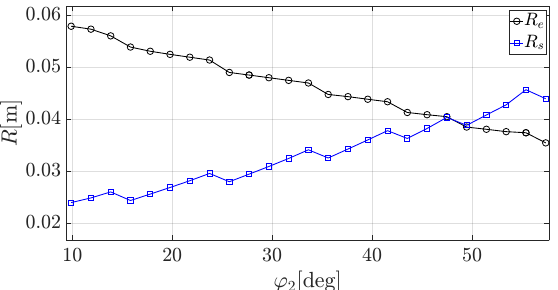
Figure 4. Entraining ( R e ) and side leakage ( R s ) radii over a mesh cycle.